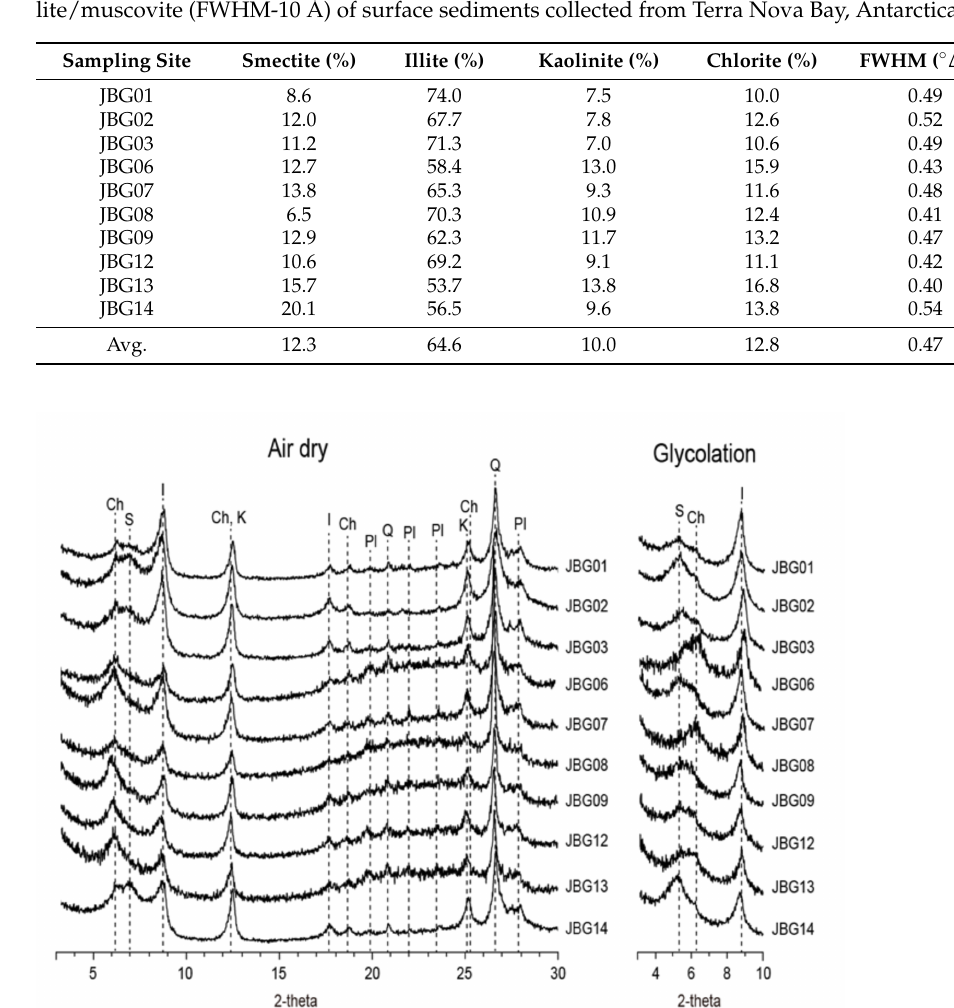
Figure 3. The XRD profiles of air-dried and glycolate-treated clay (<1 µ m) in surface sediments form Terra Nova Bay (S: smectite, Ch: chlorite, I: illite, K: kaolinite, Pl: plagioclase, Q: